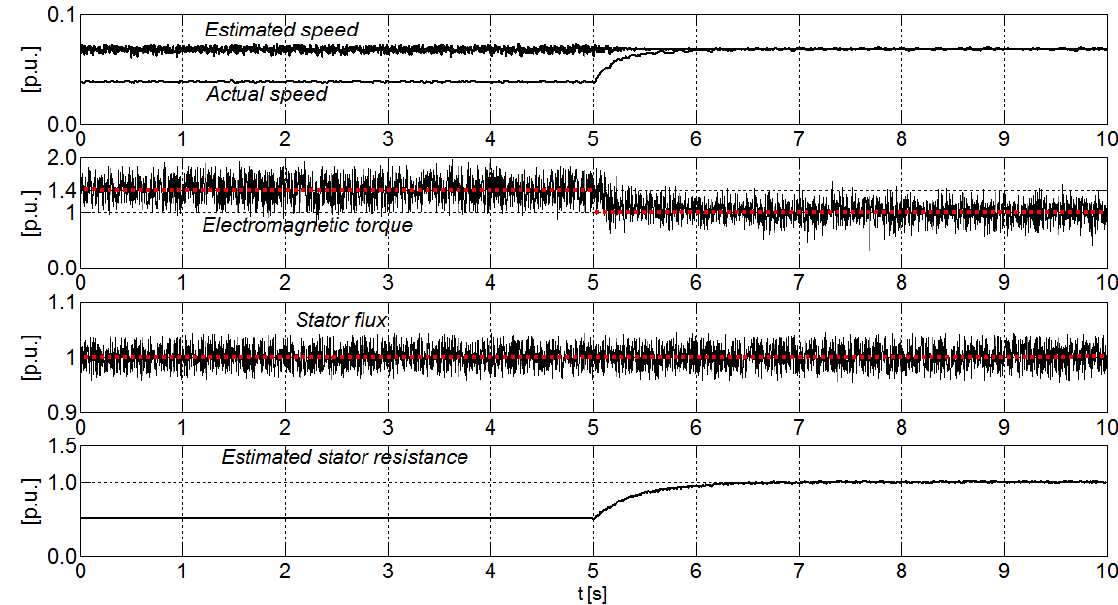
Figure 6. Experimental results of the proposed parallel estimation system under initial mismatch of stator